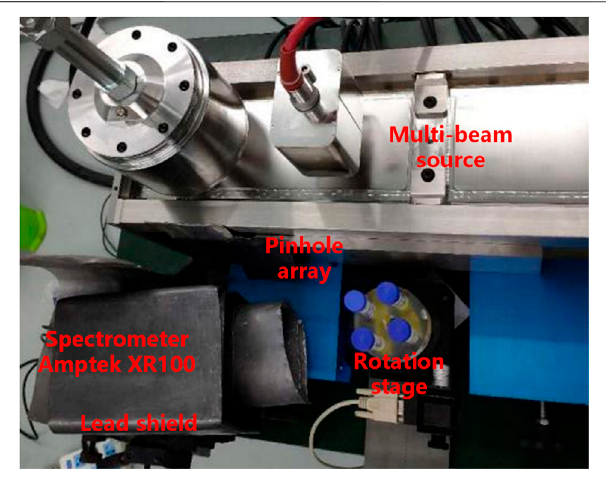
FIGURE 6 | X-ray fl uorescence computed tomography experimental device based on the spatially distributed multi-beam source.